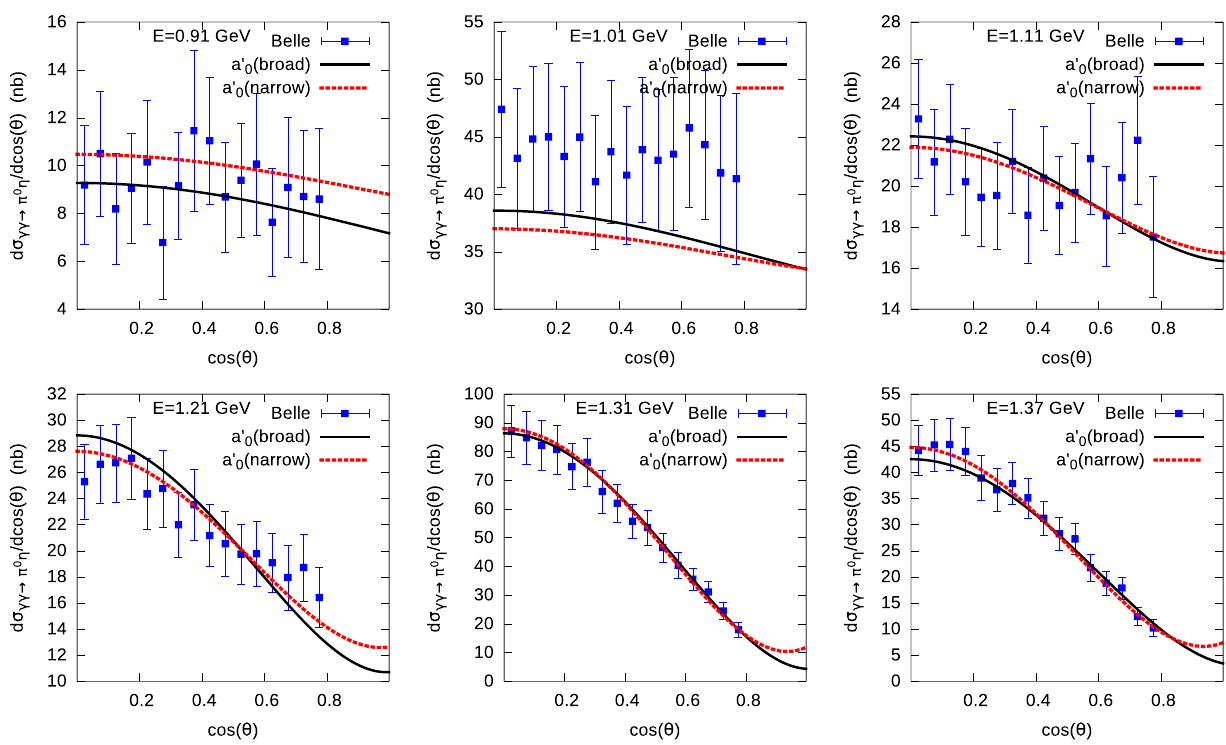
Fig. 6 Experimental γγ → πη differential cross-sections compared with the two fits results δ ( ∞ ) = 0 and η( ∞ ) = 1. These conditions introduce 22